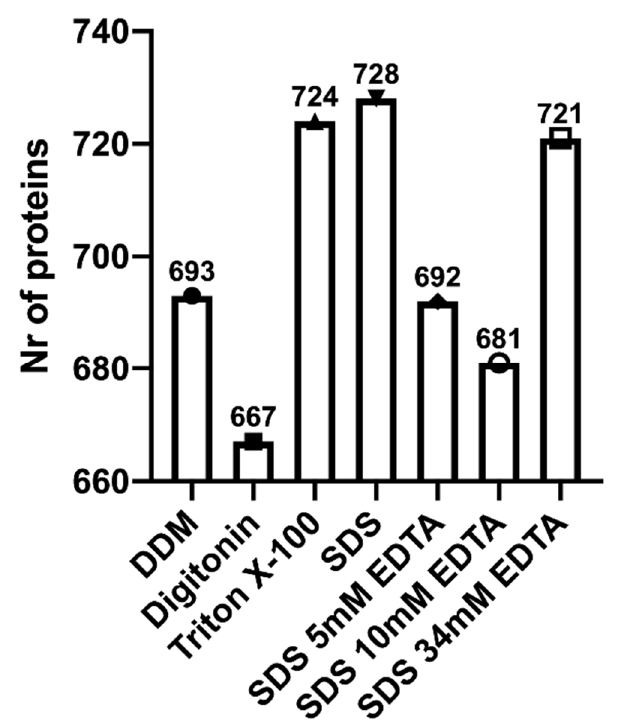
Figure 2. Number of high and medium confidence proteins identified following tandem-MS/MS analysis of human milk extracellular vesicles under seven different denaturing conditions. SDS with and without EDTA at 5 mM, 10 mM and 34 mM concentrations, Digitonin, n-dodecyl β -D-maltoside (DDM), and Triton X-100 were tested as detergents, n = 1. Mass spectrometry analysis from samples processed with each detergent revealed Triton X-100, SDS and SDS with 34 mM of EDTA to be the optimal detergent based on the highest number of proteins